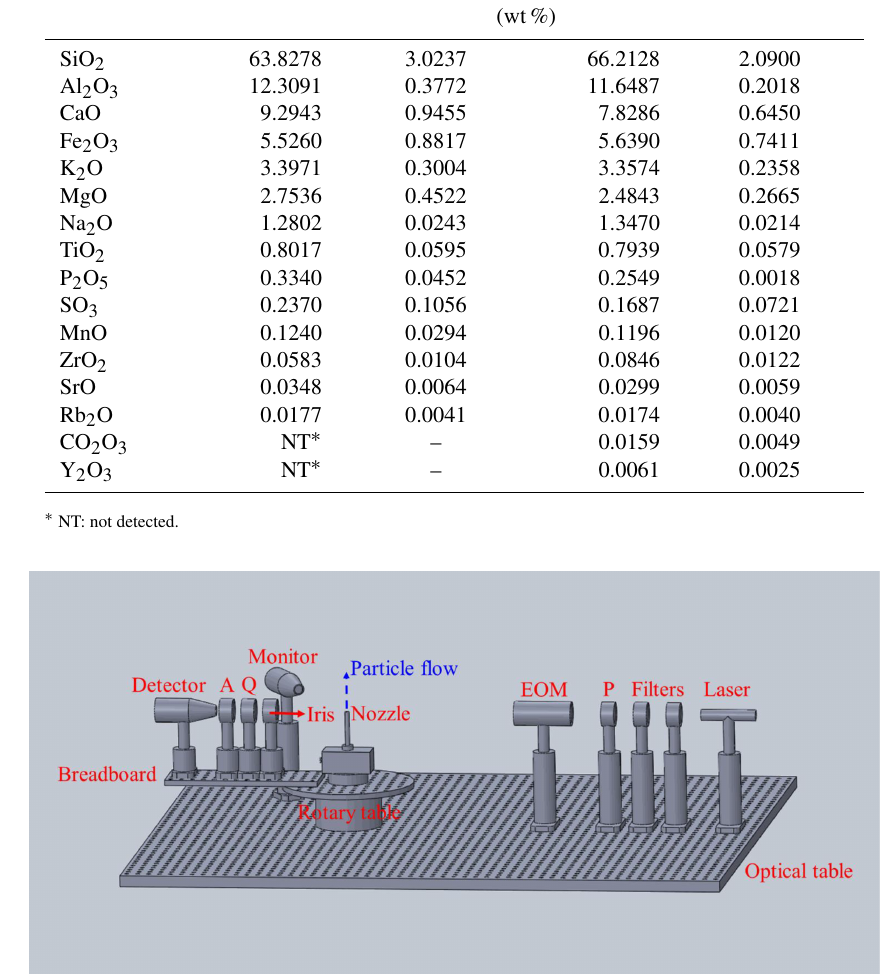
Table 2. Chemical components of pristine loess and milled loess measured by XRF-1800. Components